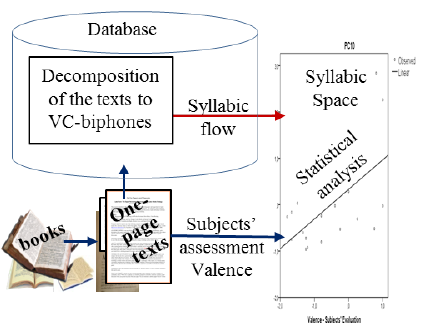
Figure 1. General scheme of the study